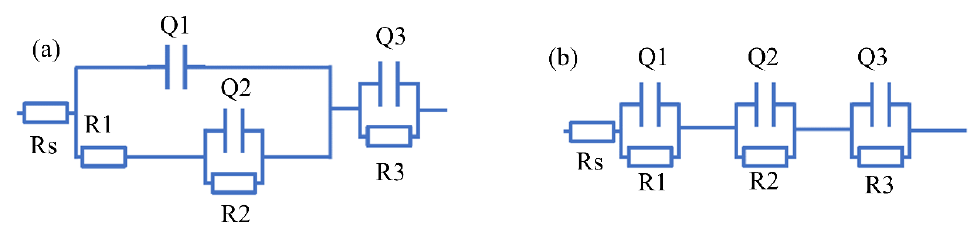
Figure 10. Corrosion test of Ta substrate, TD film, and TTTD film in weak acid environment: ( a ) Nyquist curve, ( b ) polarization curve, ( c ) phase angle diagram, ( d ) impedance value.